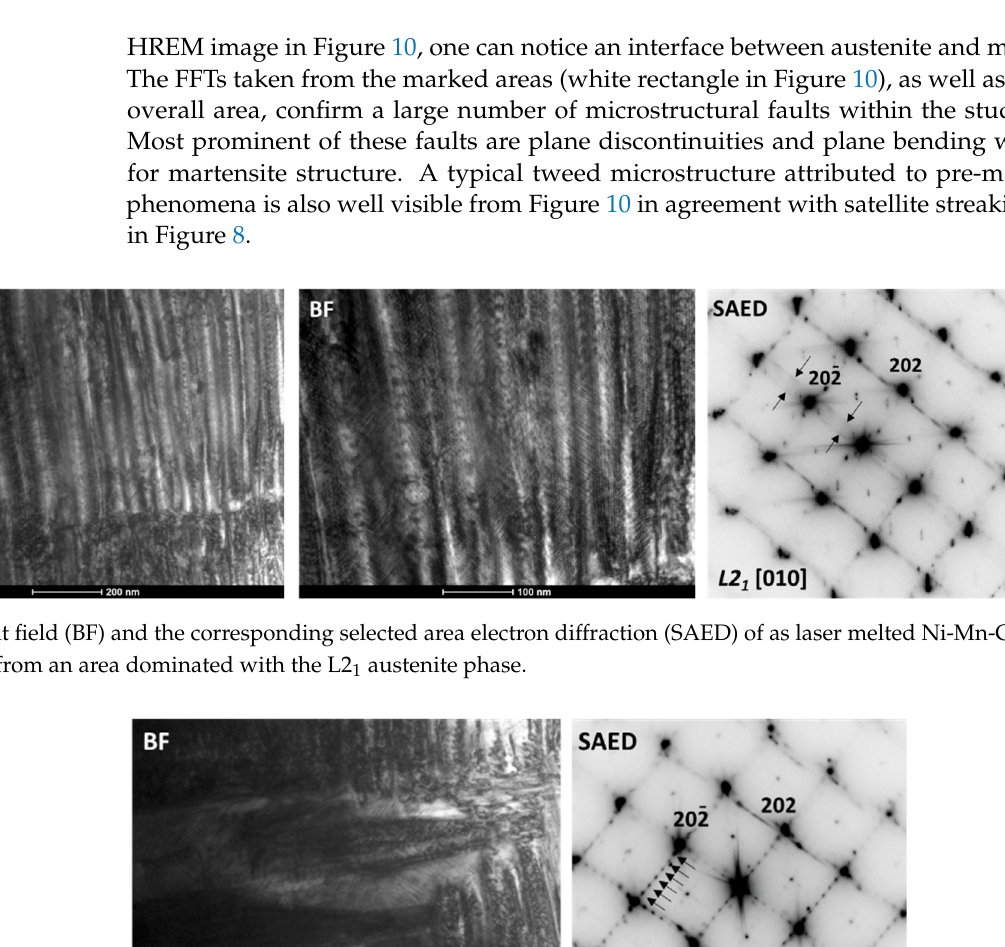
8 of 12 Figure 7. Scanning transmission electron microscopy image ( a ) and energy dispersive spectra from areas ( b , c ) correspond- ing to area marked with rectangle in ( a ) of as laser melted Ni-Mn-Ga-Fe powder. Figures 8 and 9 collect a number of BF images and the corresponding selected area electron diffraction patterns (SAED). The SAED in Figure 8 can be well indexed according to the L2 1 austenite structure along the [001] zone axis. Interestingly this SAED shows diffuse streaking, indicated by arrows and originating from (202) planes, which were often found with premartensitic phenomena. The SAED in Figure 9, on the other hand, can be well indexed according to the 14M modulated martensite structure, which was given